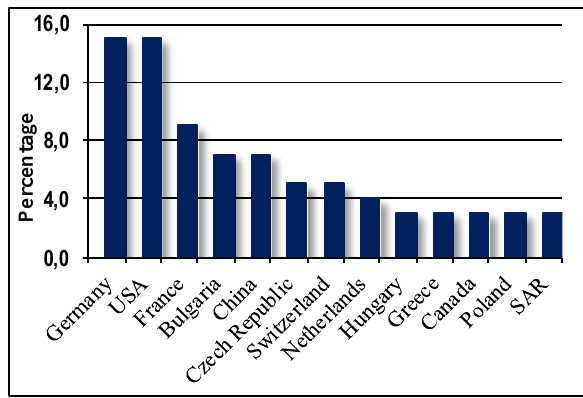
Figure 9. Countries that made major contribution in